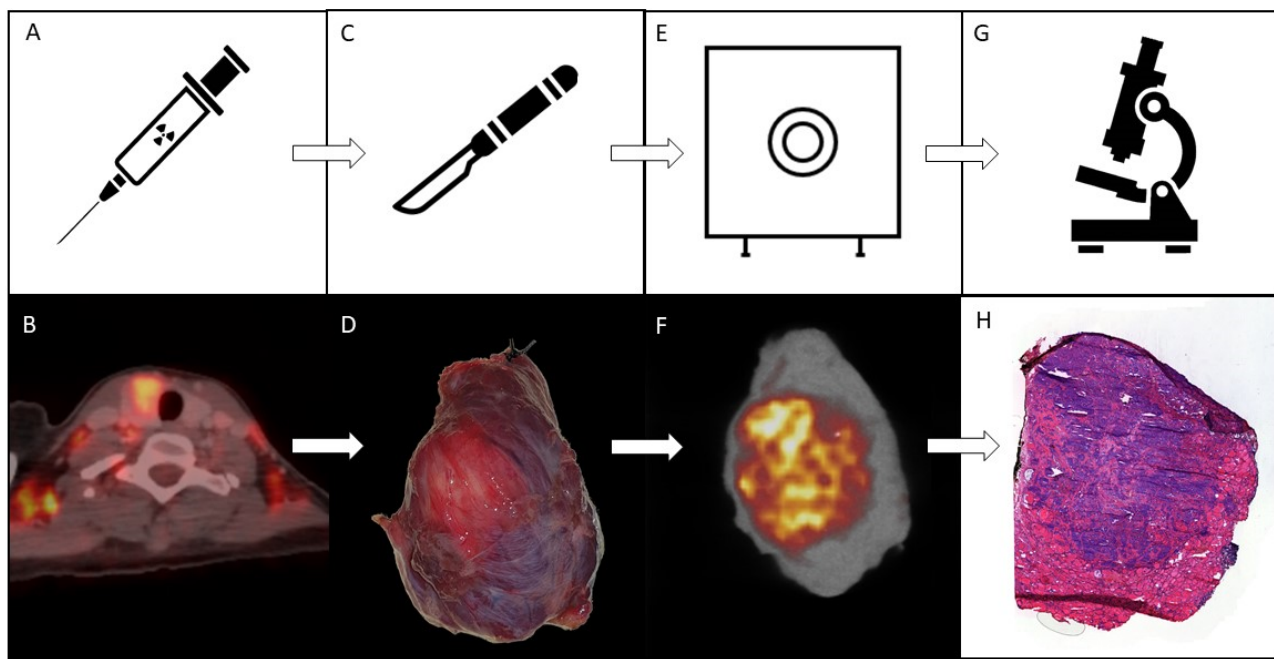
Figure 1. Schematic overview of the used methodology. The top row displays a simplified overview of the used methodology for the trial. The bottom row displays the step-by-step imaging results visualized in patient 7. ( A ): the patient is given 4 MBq/kg of 18 F-FDG approximately on hour prior to planned surgical initiation. ( B ): Pretherapeutic clinical whole body 18 F-FDG PET/CT taken during clinical routine staging. This image illustrates the increased 18 F-FDG uptake in the left hemithyroid approximately 60 min after 18 F-FDG administration. ( C ): Surgery is performed as standard of care. ( D ): Photographic image of the resected hemithyroid containing the solid malignant mass. ( E ): The resected specimen is scanned using preclinical high resolution PET- and CT-imaging devices. ( F ): High-resolution PET/CT-imaging of the full specimen displayed in ( D ). ( G ): When scanning is finalized, the specimen is processed for pathological assessment as standard of care, enabling margin assessment. ( H ): Hematoxylin-eosin staining of a pathological slide including both malignant and healthy tissue, characterized by more hematoxylin (purple) and eosin (pink) staining, respectively.